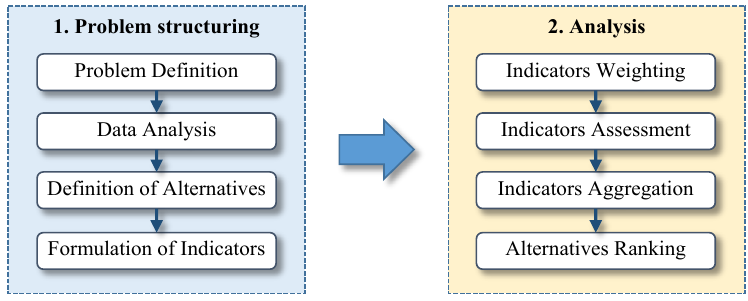
Fig. 1. Conceptual scheme of proposed